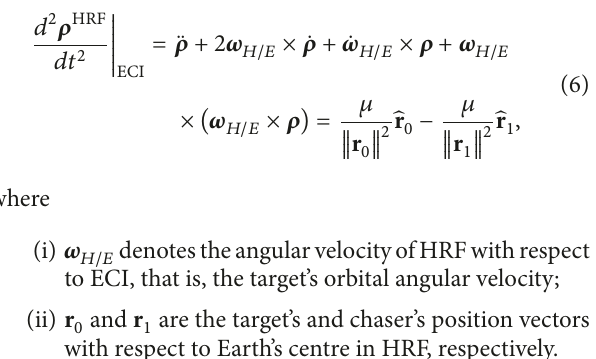
Figure 2: Geometrical representation of the azimuth and elevation angles definition. In black: the Hill Reference Frame. In grey: the target’s body, centred in the origin of the HRF. In red: the 𝜌 vector, pointing from the target’s centre of mass towards the chaser’s centre of mass. In green: the azimuth angle 𝜓 and the elevation angle 𝜙